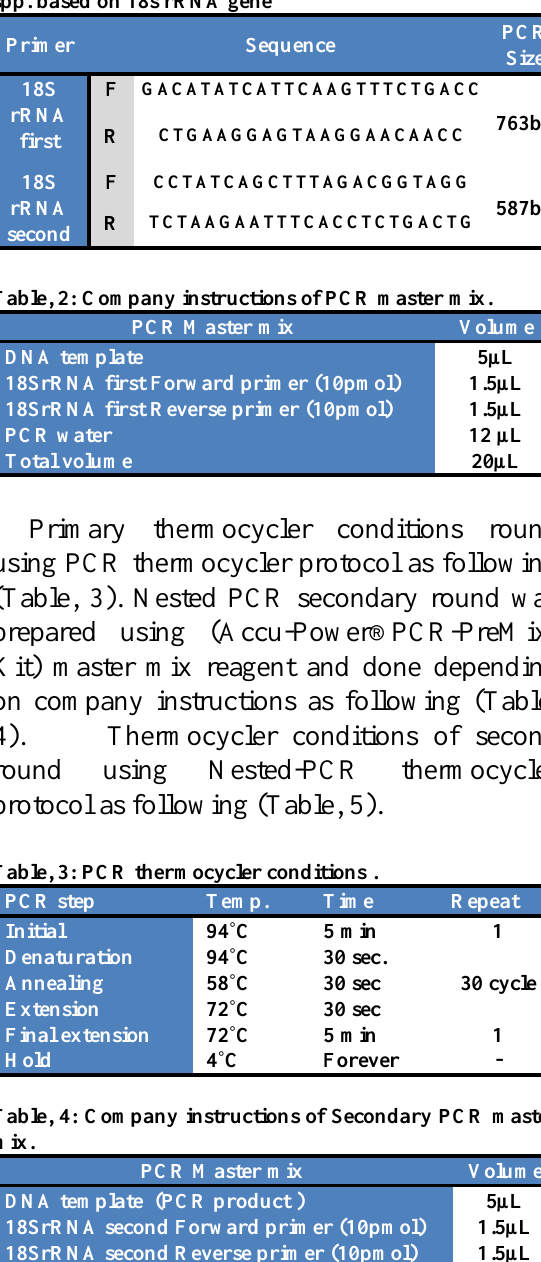
Table, 1: PCR primers for detection of Cryptosporidium